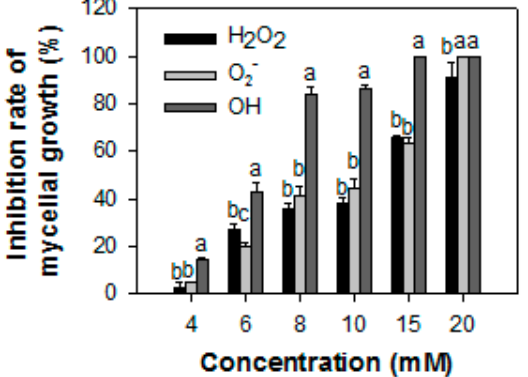
Figure 2. The inhibitory effect (%) of reactive oxygen species on the mycelial growth of Colletotrichum gloeosporioides from papaya fruit. The data were expressed as the means ± SE of three biological replicates. Different letters in the same column indicate significant differences.